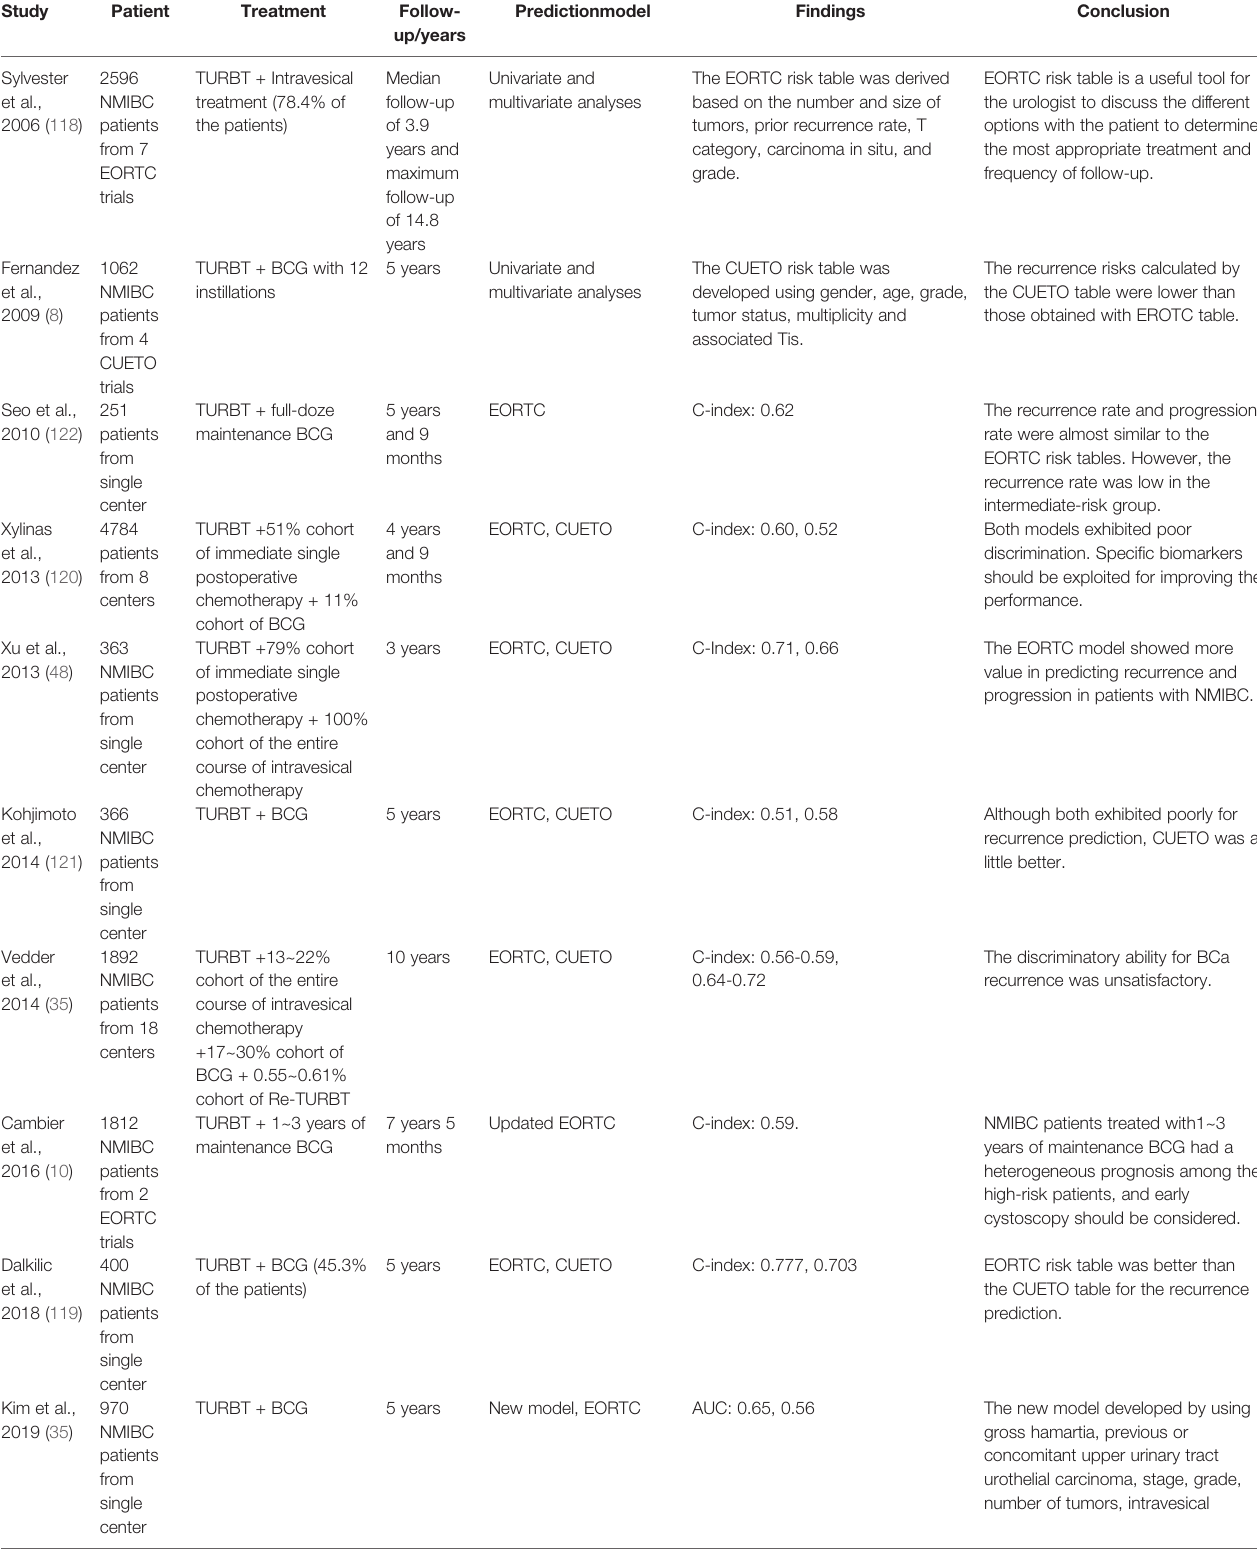
TABLE 4 | Related studies and strategies of BCa recurrence risk prediction during the past 20